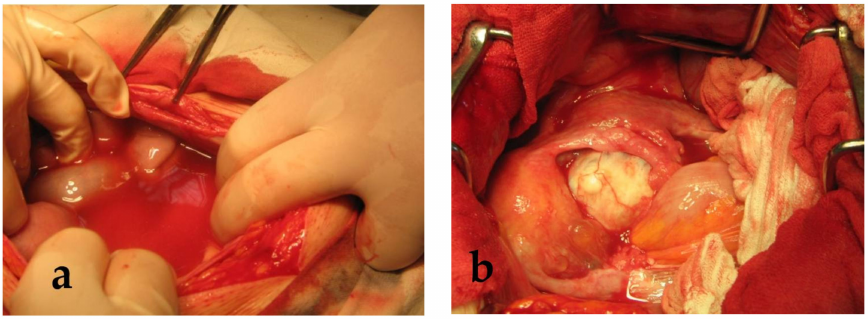
Figure 1. ( a ) The ascites fluid; ( b ) Intra-operative aspect of the ovarian